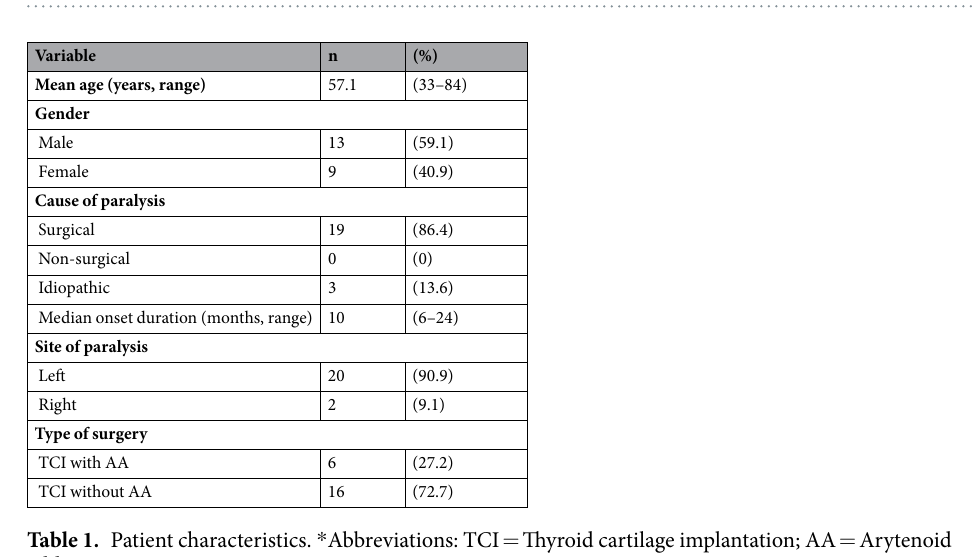
Figure 2. Schematic illustration of the coronal view of the larynx. ( A ) Right vocal fold was paralyzed with glottal insufficiency. ( B ) The graft was inserted into the window, and the paralyzed vocal fold was medialized. The authors would like to thank Biao-Wei Chen for drawing Fig. 2.